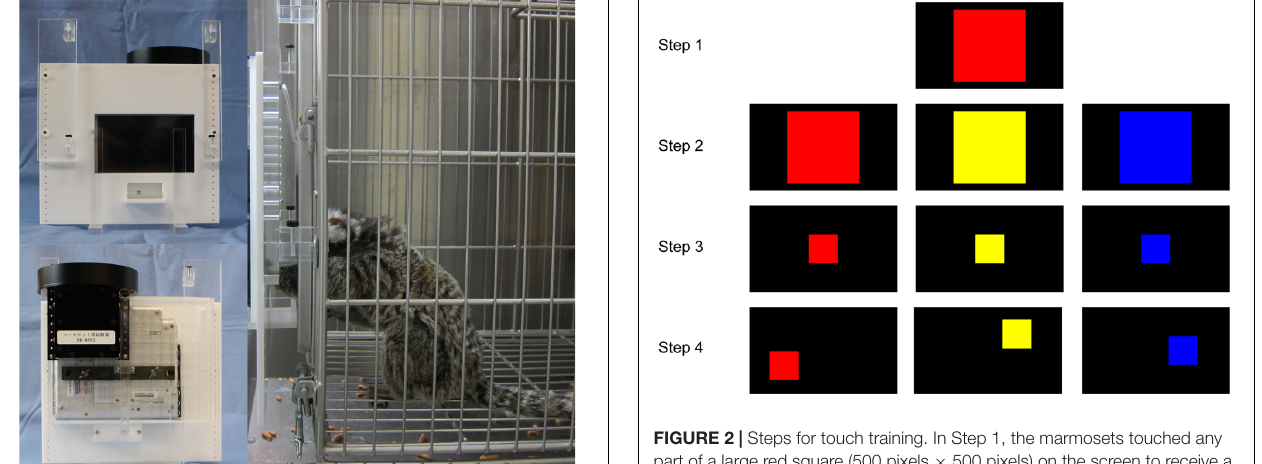
Step 1, the marmosets initially received a reward for touching any point within a large red square (500 pixels × 500 pixels) randomly set to red, yellow, or blue in different trials. In Step 3,